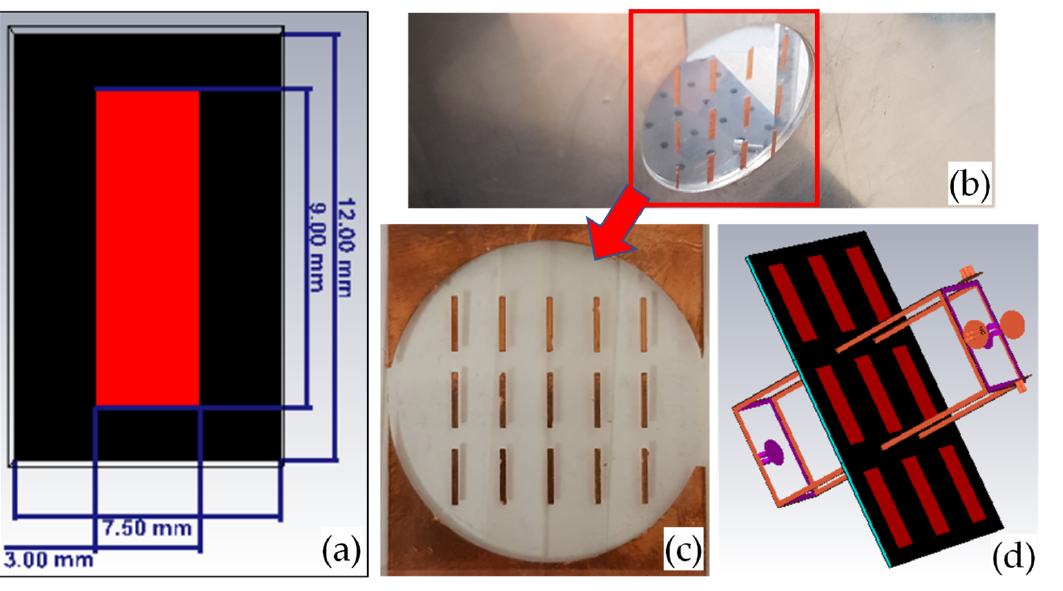
Figure 13. FSS design of: ( a ) VO 2 showing a hot state (red) modelled as a lossy metal with an electrical conductivity of 1.2 × 10 3 S/m and cold state (black) modelled as “normal material” with a dielectric constant, ε r , of 34 and an electrical conductivity of 1.2 S/m in CST software; ( b ) Cu FSS structure on the sample holder; ( c ) Cu FSS array on a glass substrate; ( d ) Modelling FSS structure on sapphire in CST software.